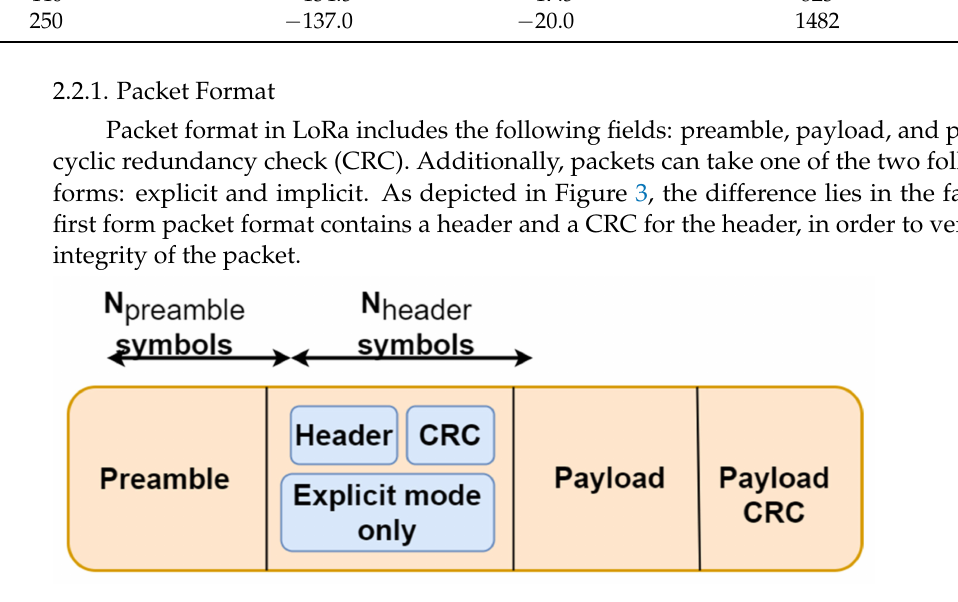
Figure 3. LoRa packet